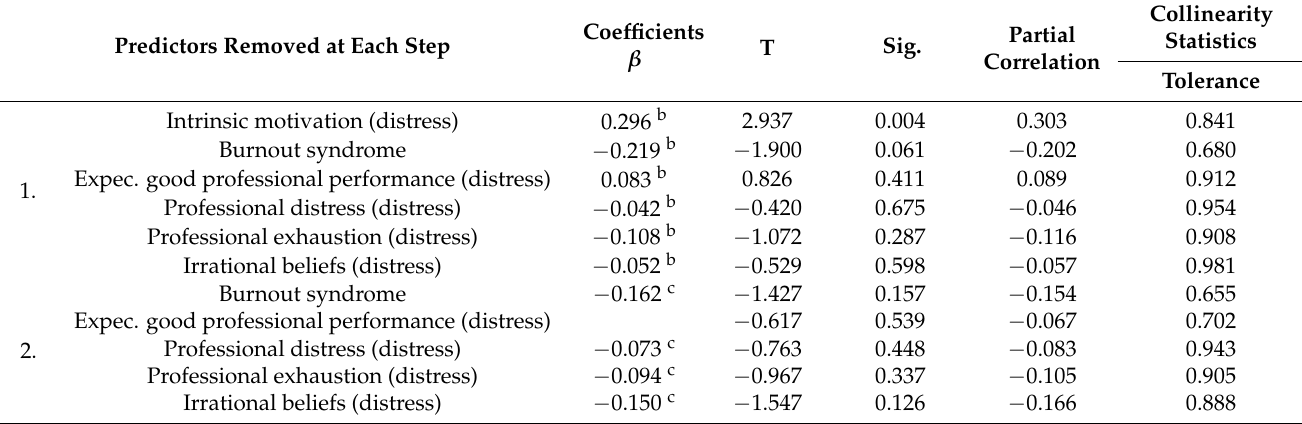
Table 2. Predictors eliminated in the model in each step (steps 1 and 2). Source: own